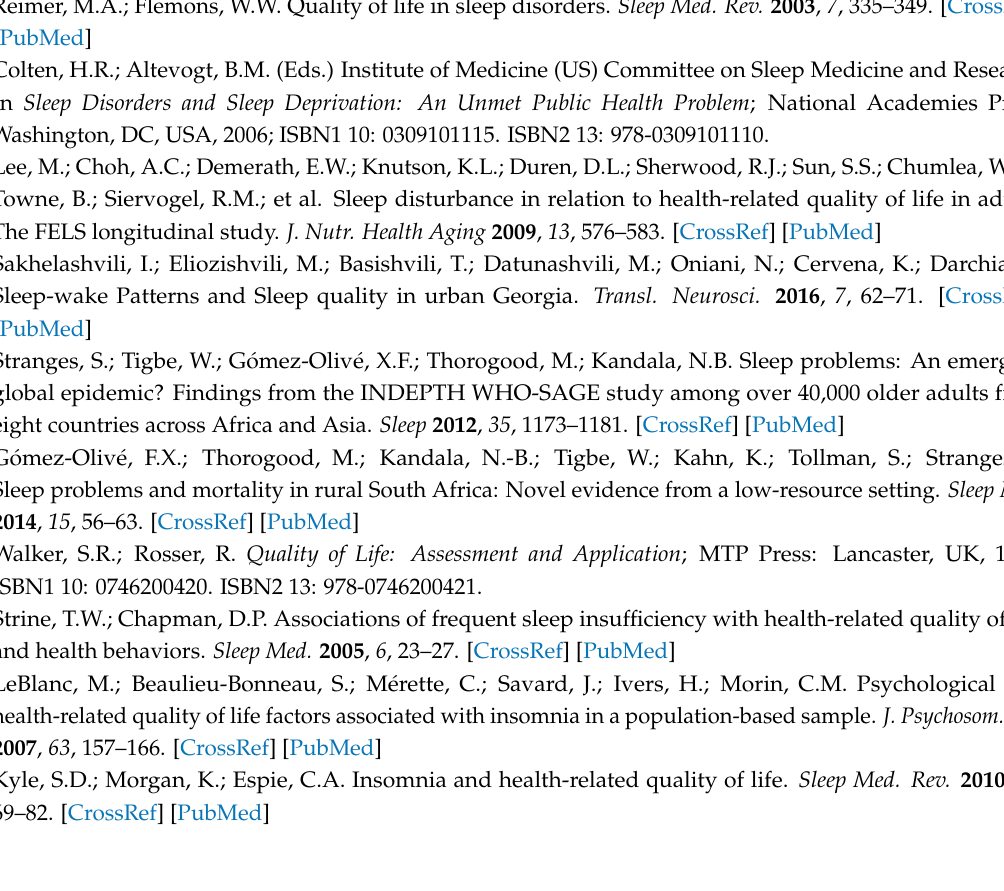
s1. Table S1: Hierarchical multiple regression analyses of the associations between daytime sleepiness (A), OSA risk (B) and insomnia (C) and HRQoL summary